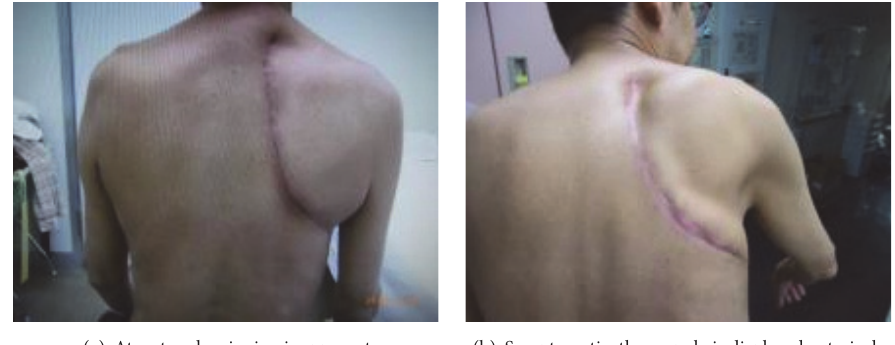
Figure 1: After lung cancer surgery (right thoracotomy).